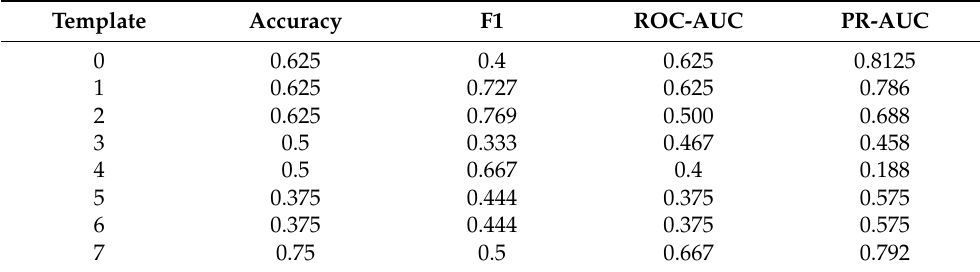
Table 2. Classification in eight test data of bipolar voltage on AF type through LOOCV.